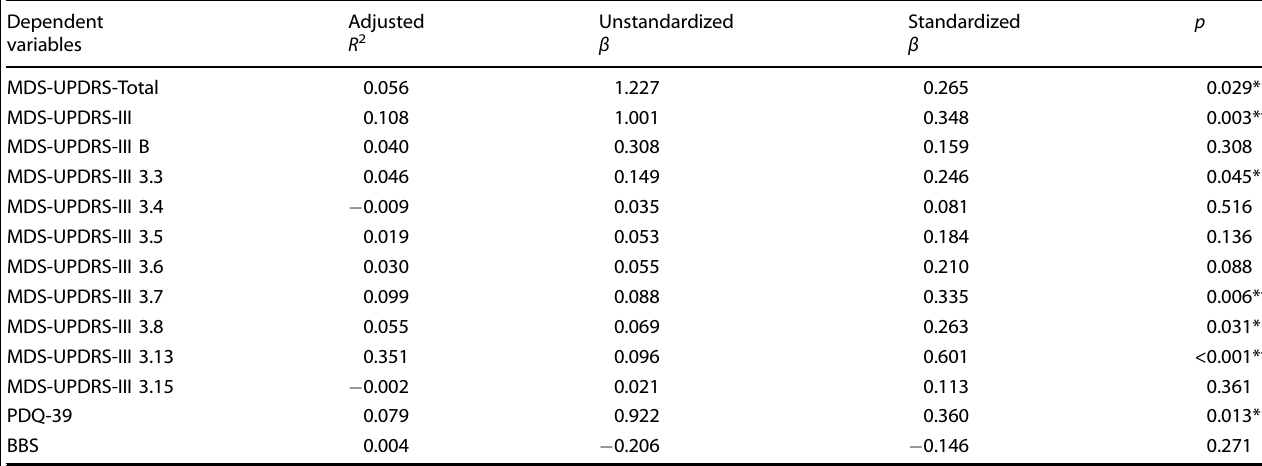
Table 3. Linear regression analysis to determine the proportion of the variance in clinical measurements explained by the IPA.